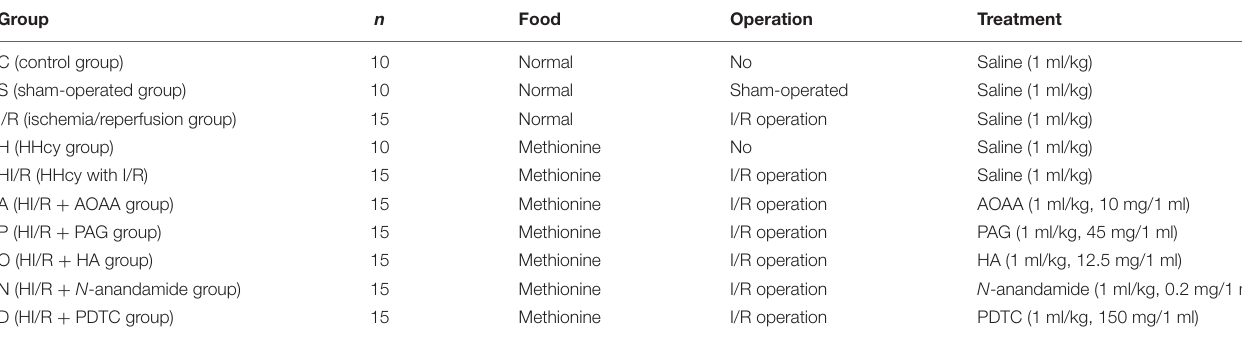
TABLE 1 | The detailed data of experiment groups of SDA